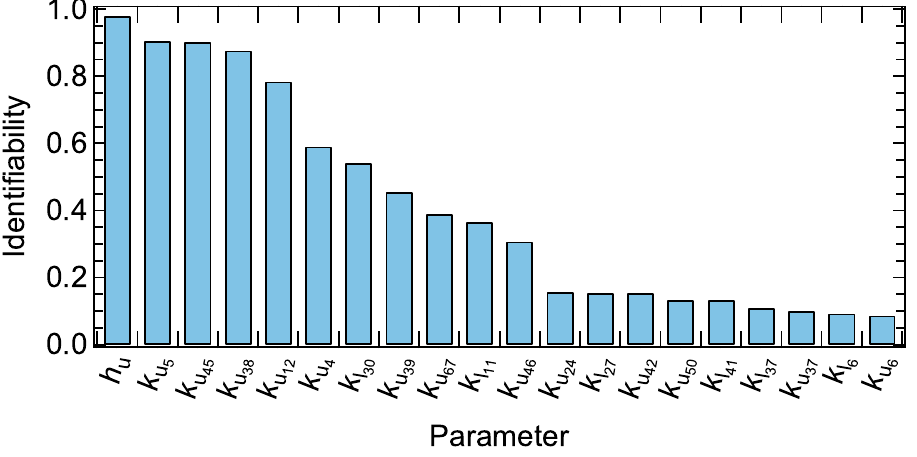
Figure 8. The 20 most identifiable parameters.